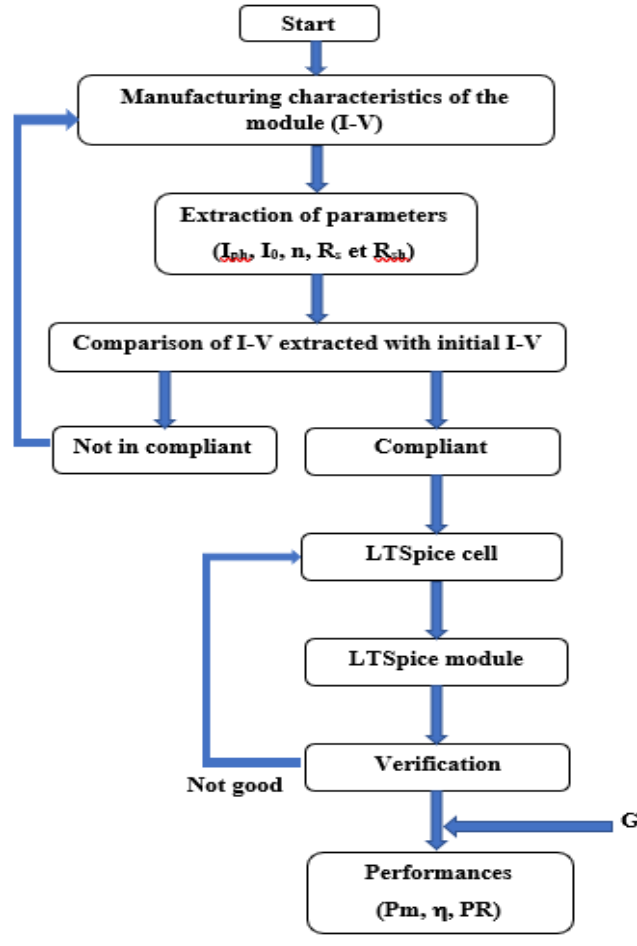
Figure 1. Organization chart of the